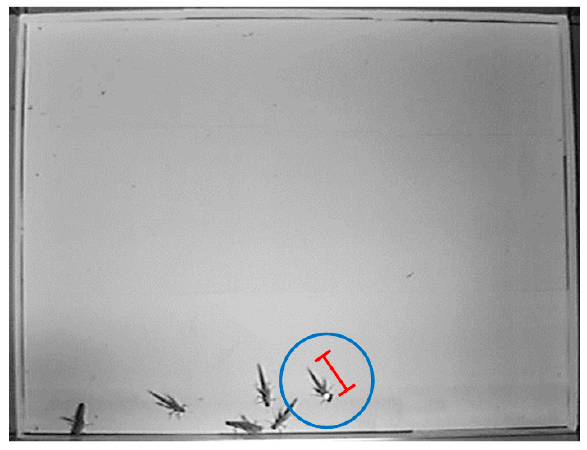
Figure 1. Snapshot of the top view camera. Blue circle: The target individual with the reflecting tape on the thorax. The red scale bar indicates the body length of the target individual, which was used as the minimum distance to define group formation.